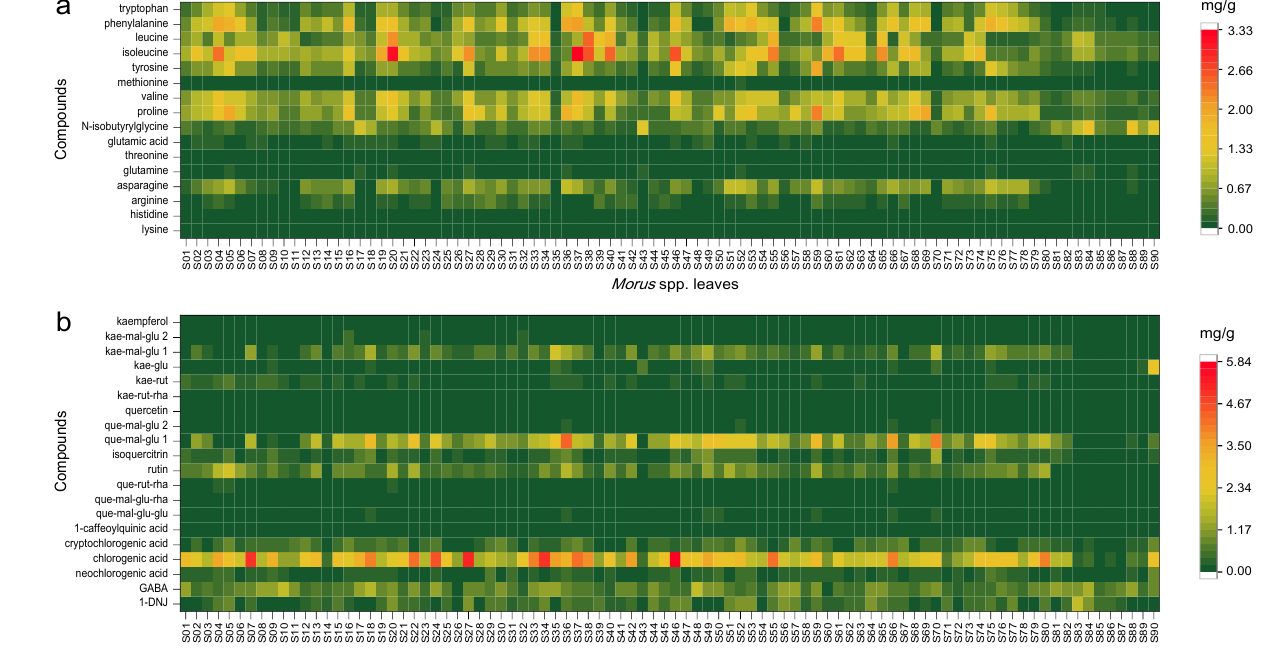
Figure 5. Amino acids ( a ) and typical bioactive compounds ( b ) in different Morus spp. leaves.